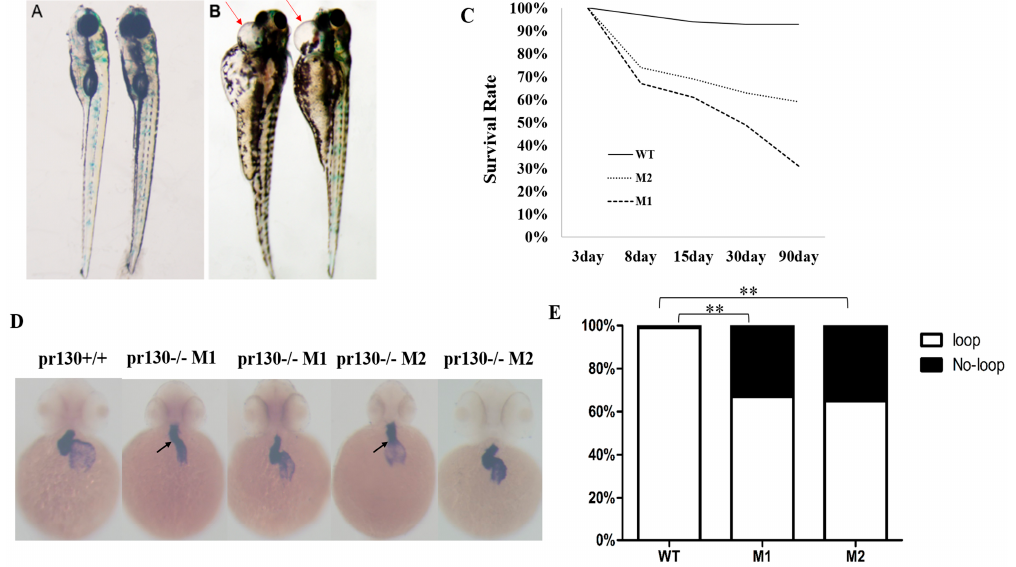
Figure 3. Effects of pr130 deletion on mortality and cardiac development. ( A , B ) pr130 − / − embryos develop pericardial edema ( arrow ). A , WT; B , pr130 − / − ; ( C ) Survival curves; ( D ) Whole-mount in situ hybridization (WISH) using the heart probe cmlc2 . Mutants showed a higher proportion of no-looping ( arrows ) compared with WT which showed normal heart looping; ( E ) Percentage of abnormal and normal heart looping. n = 100 embryos analyzed per panel. The symbols ** in the bar chart represent significant differences ( p < 0.01).